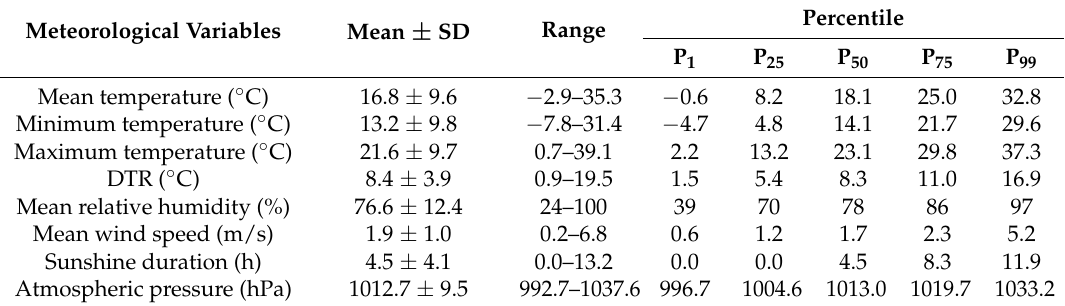
Table 1. Distribution characteristics of daily meteorological variables in Wuhan, China, 2009–2012.